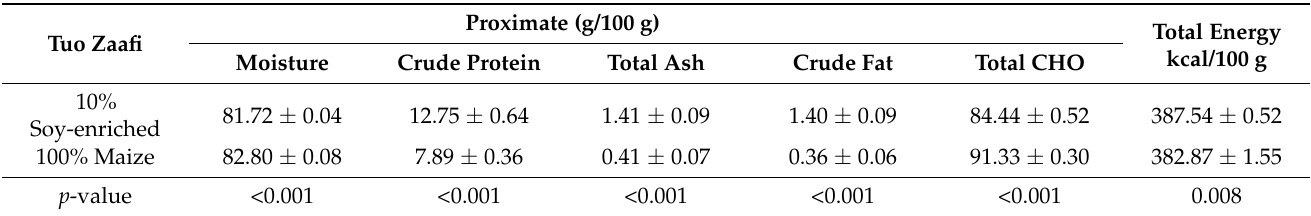
kcal/100 gMoisture Crude Protein Total Ash Crude Fat Total CHO